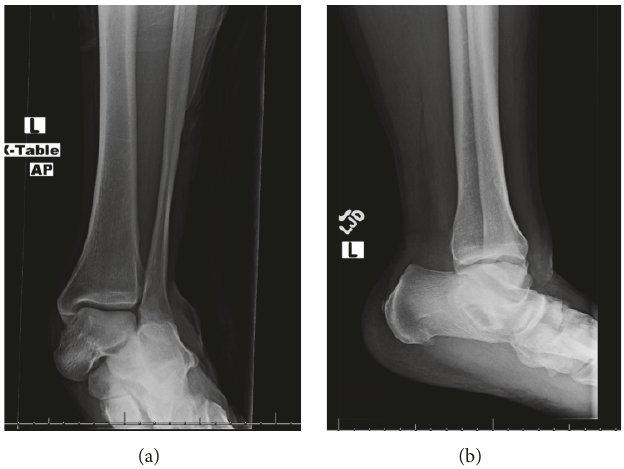
Figure 1: Injury radiographs demonstrating the subtalar dislocation.